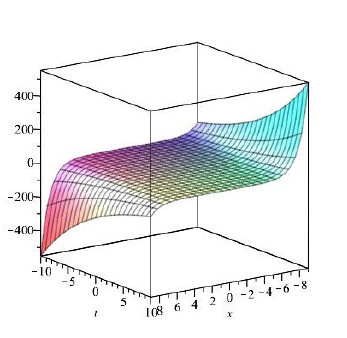
Figure 2. 3D plot of w ( x,t ) of solution (3.12) by considering C 2 = 0 , C 3 = 1 , C 4 = − 1